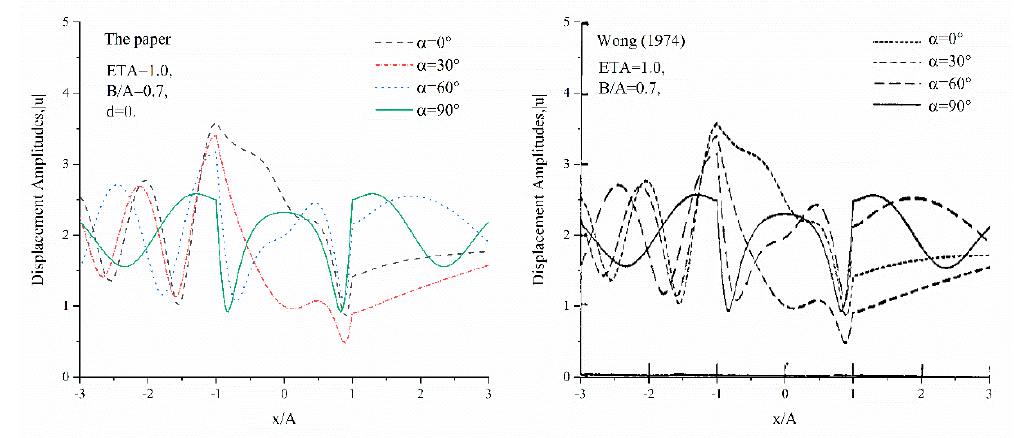
Figure 3. Comparison with the case of a semi-elliptical canyon by Wong [13].